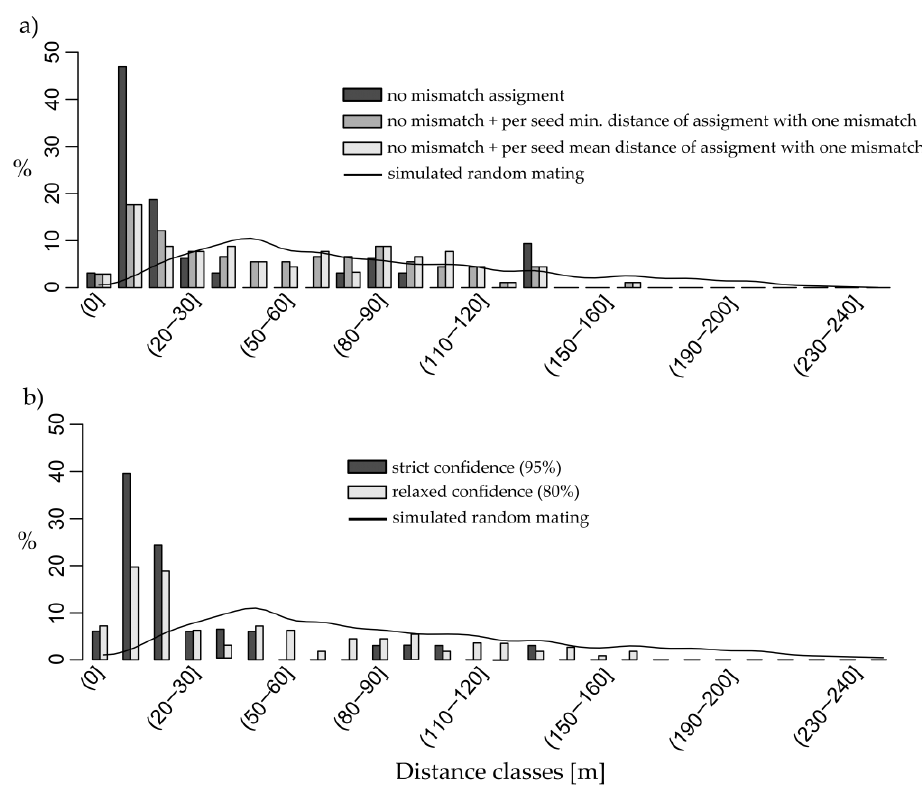
Figure 3. Relative frequency of local, within the stand, pollen dispersal in 10 m. distance interval classes and the 0 m distance class indicating self-fertilisation: ( a ) dark grey bars represent strict assignments without any mismatch at the genotyped simple sequence repeat (SSR) markers, grey bars represent strict assignments combined with assignments allowing for only one mismatch, where in cases of multiple possible assignments for a seed the nearest pollen donor was considered, and light grey bars represent the same conditions as previous, but mean distance is used in cases of multiple assignments; ( b ) dark and light grey bars represent assignments made by CERVUS 3.0.7 with 95% and 80% confidence, respectively. The simulated random mating distance of the sampled mother trees and the reference population is given as cubic spline interpolated black curve of 20,000 events. Both observed and simulated data do not include pollen flow from outside the